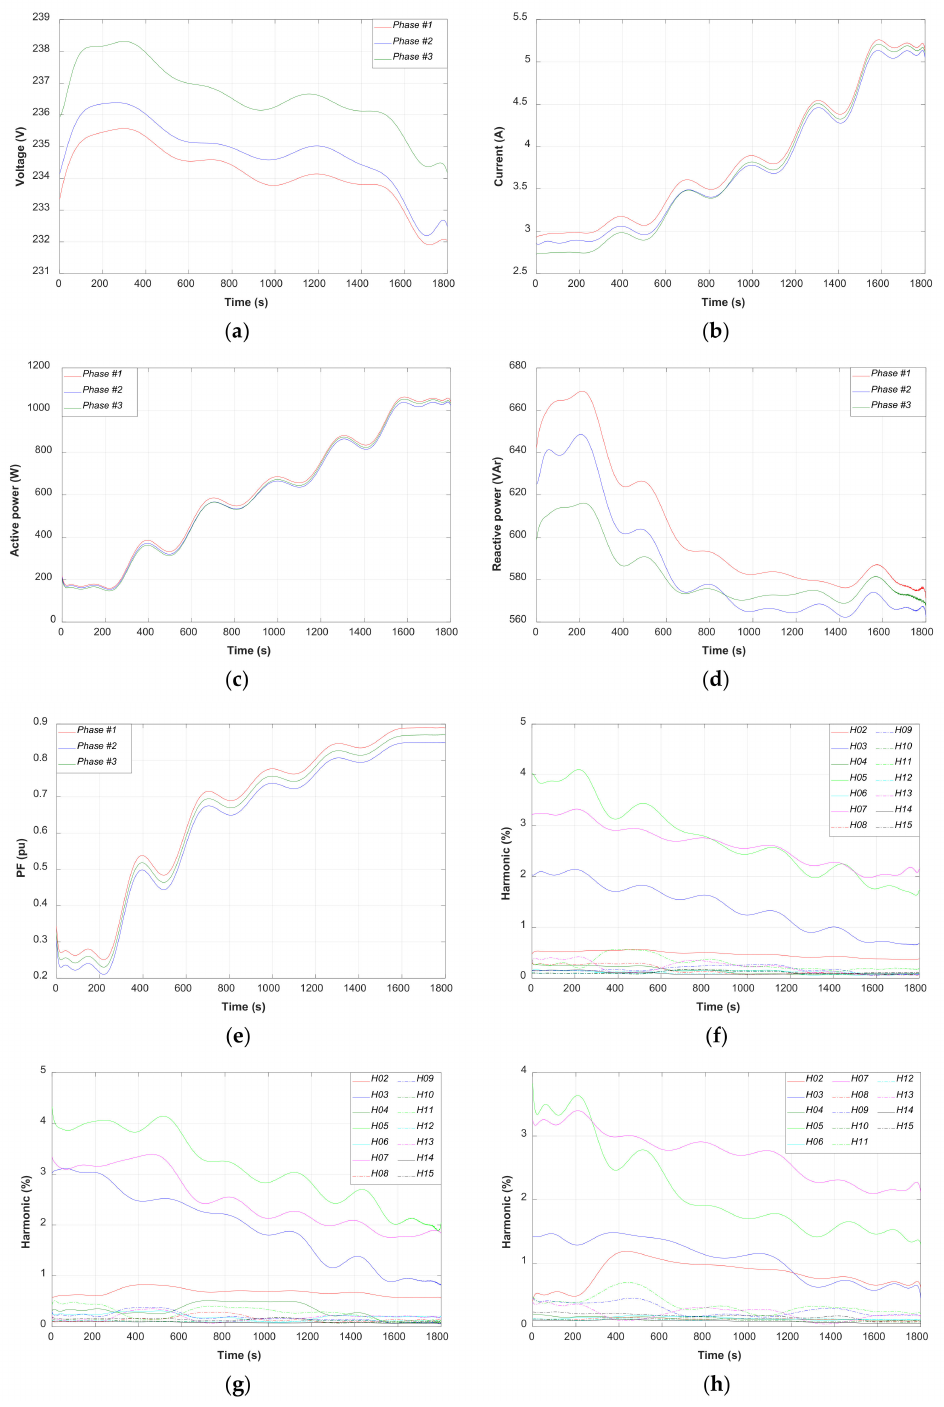
Figure 20. Measured data per phase for a three-phase asynchronous motor with a squirrel-cage rotor: ( a ) voltages; ( b ) currents; ( c ) active powers; ( d ) reactive powers; ( e ) power factor; ( f ) Phase #1 current harmonics; ( g ) Phase #2 current harmonics; and ( h ) Phase #3 current